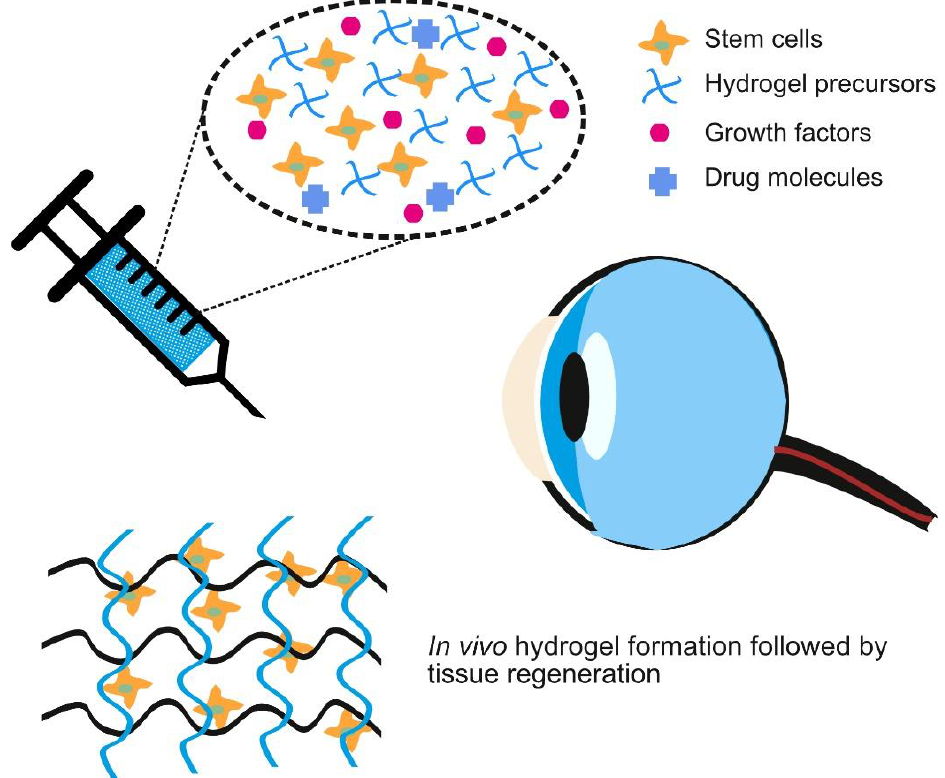
Figure 3. Schematic representing the potential different components of an injectable hydrogel to be used for corneal repair.